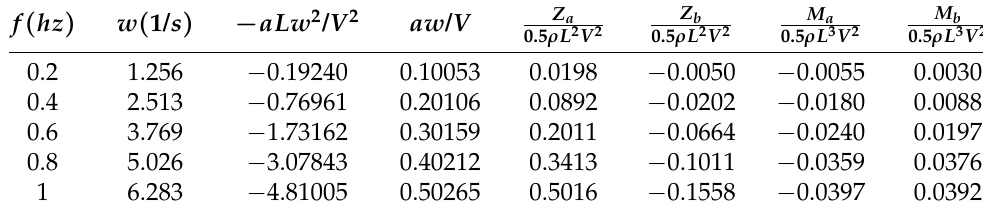
Table 2. Numerical estimation of heave motion simulation of the Shark-AUV.